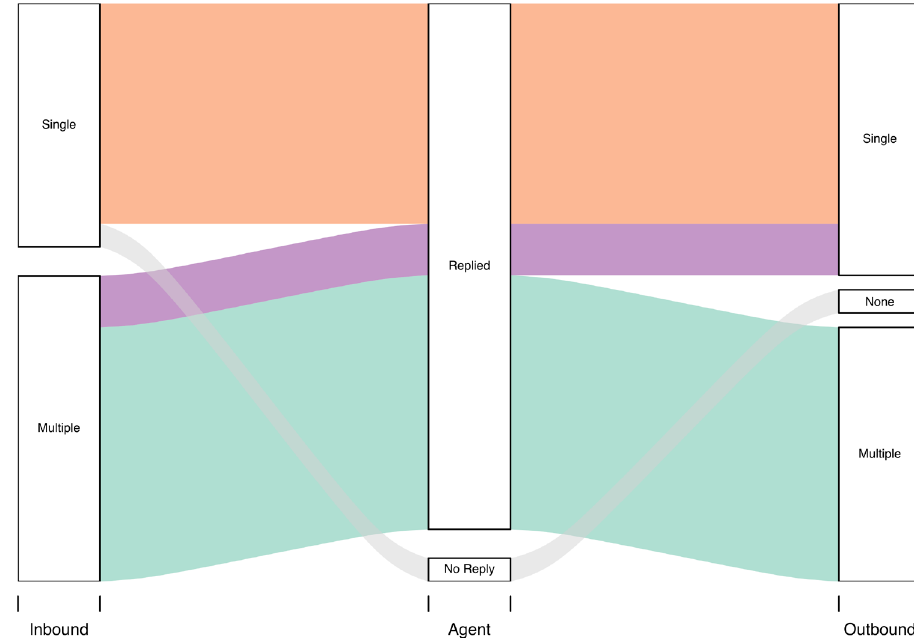
Figure 2. Alluvial diagram of inbound and outbound